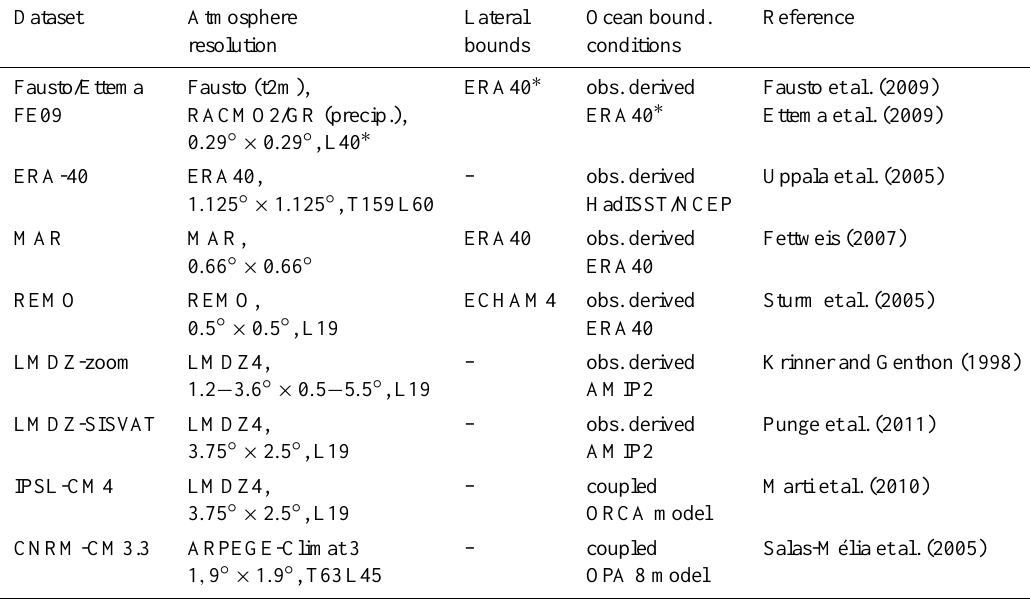
Table 2. Main characteristics of atmospheric forcing fields used for this